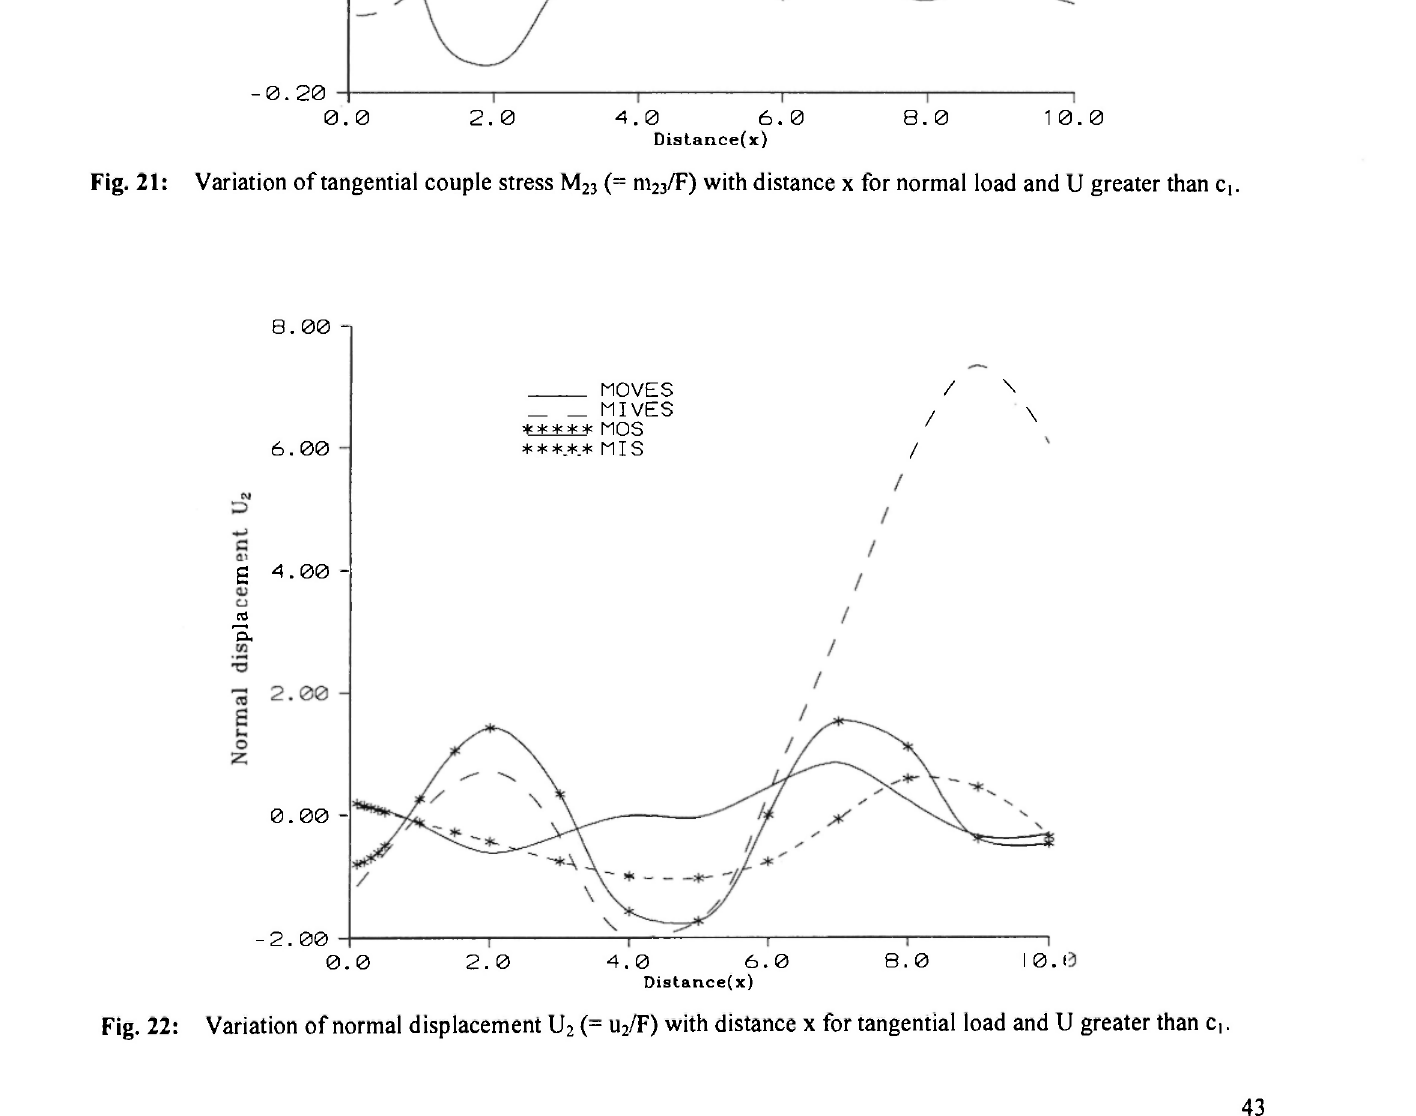
Variation of normal displacement U 2 (= u 2 /F) with distance χ for tangential load and U greater than